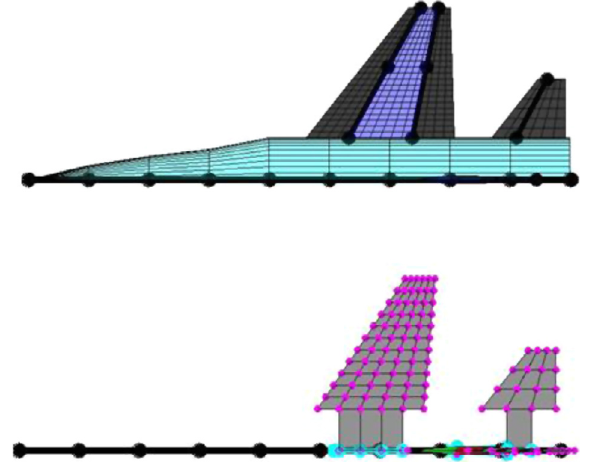
Figure 2. The MSTCGEOM application creates discrete geometry for ASTROS, FRICTION, TORNADO, AWAVE, WINGDES, and MSTCPERF applications (baseline ESAV half-span